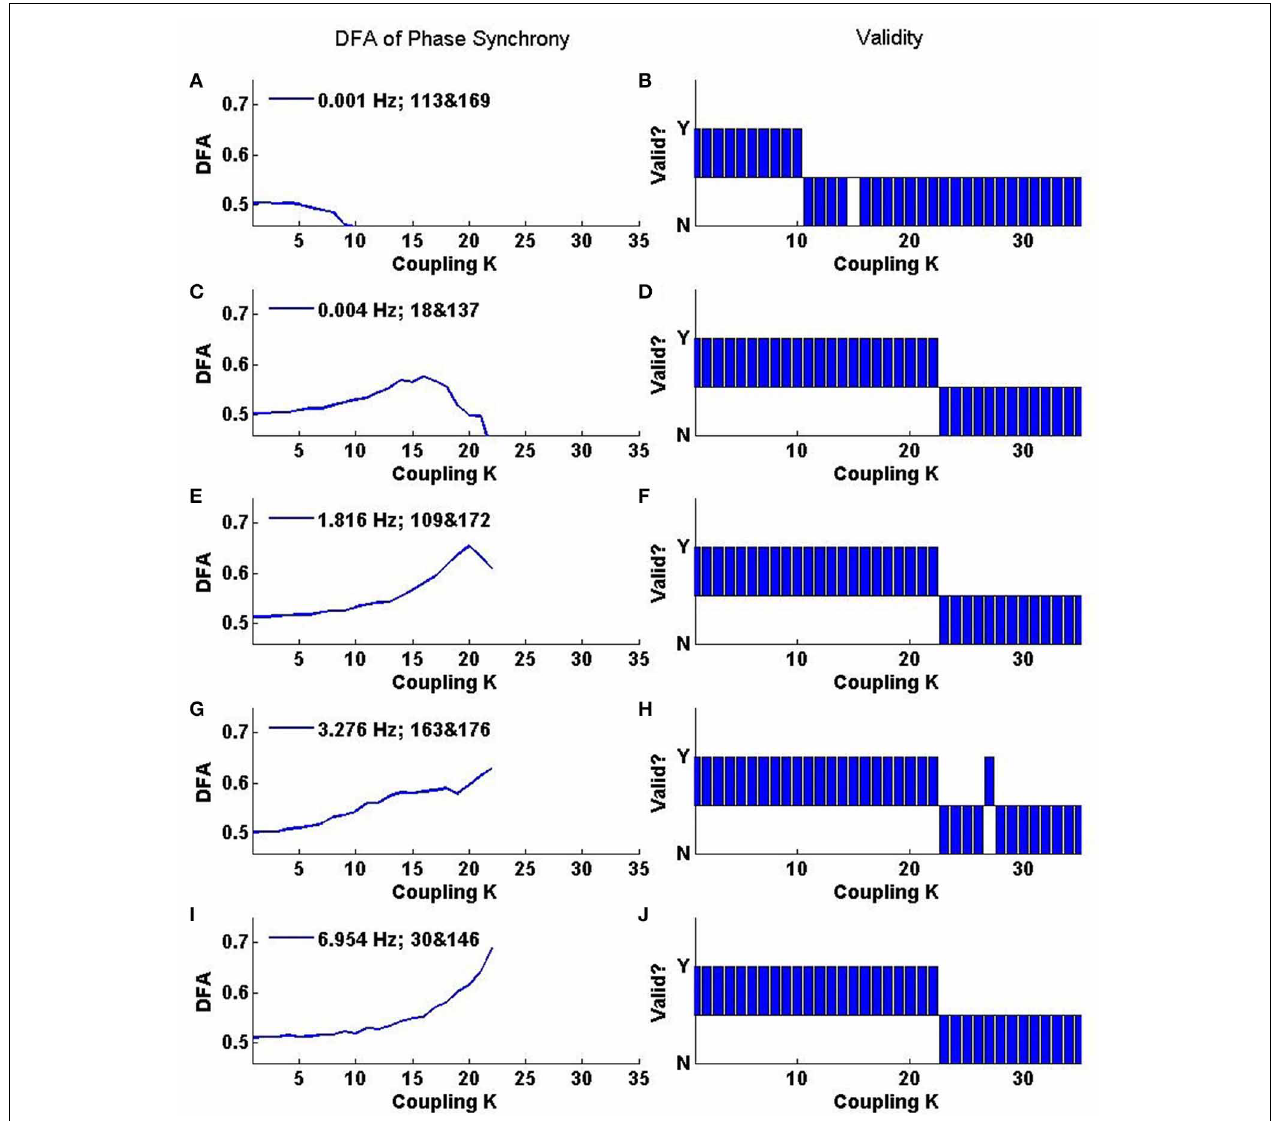
FIGURE 9 | Representative relationship of DFA exponents to the coupling parameter K for selected oscillator pairs in the Kuramoto system. (A,C,E,G,I) Show the value of valid DFA exponents, while (B,D,F,H,J) indicate whether the exponent is rejected as invalid by the